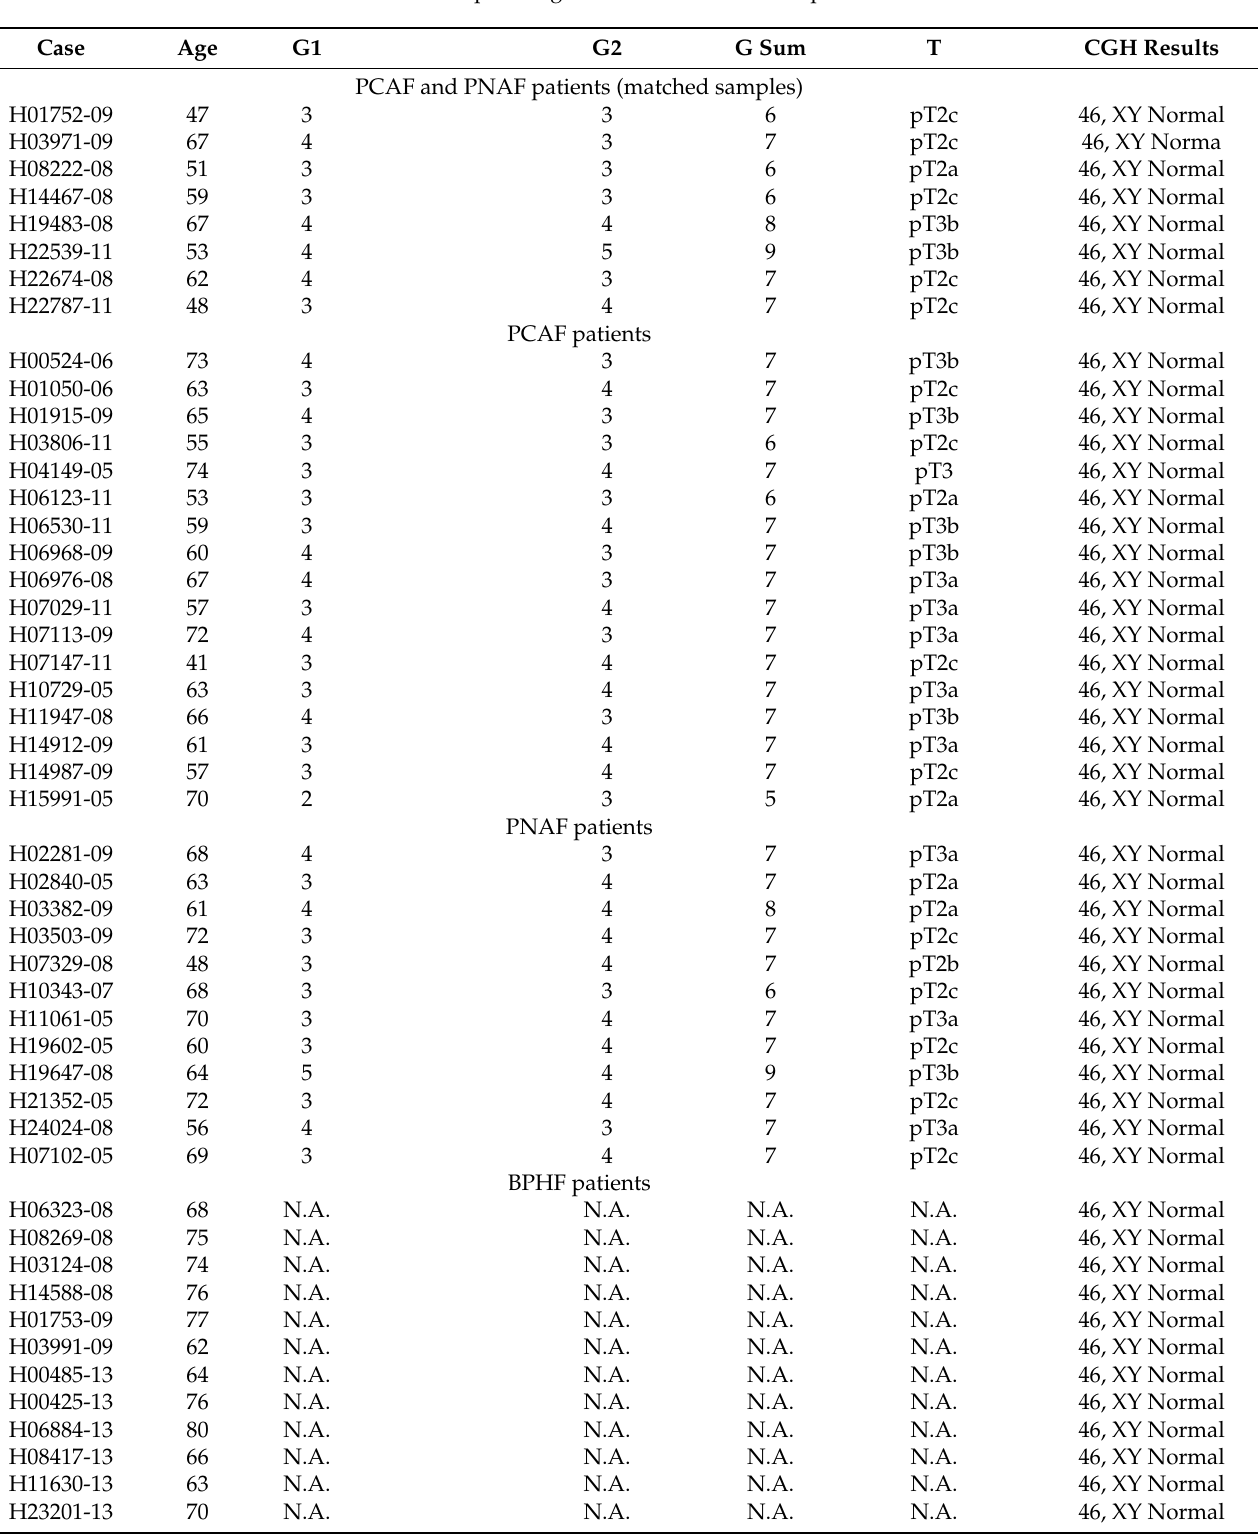
Table 1. Clinical-pathological characteristics of the patients.